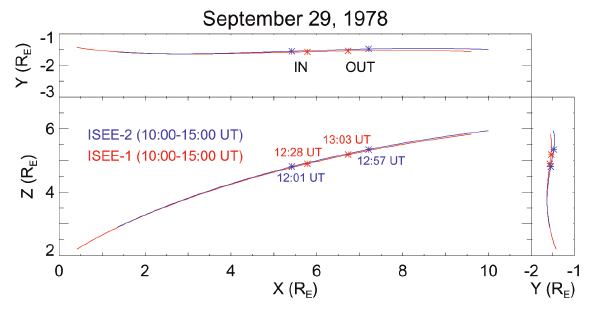
Fig. 1. The orbital projections of ISEE-1 and ISEE-2 around the event are shown in GSM. The first star indicates when each space- craft starts to observe the CEPs, and the second star indicates when the spacecraft no longer observes the CEPs.